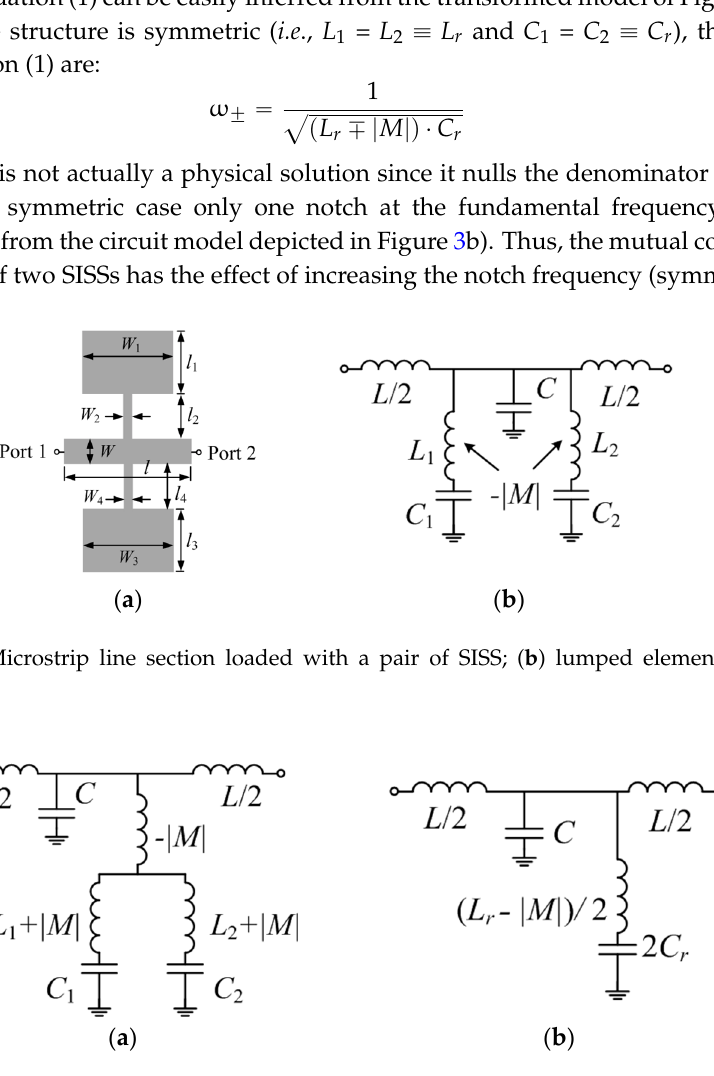
Figure 3. ( a ) Equivalent circuit model to that of Figure 2b; ( b ) Equivalent circuit model for the symmetric case.